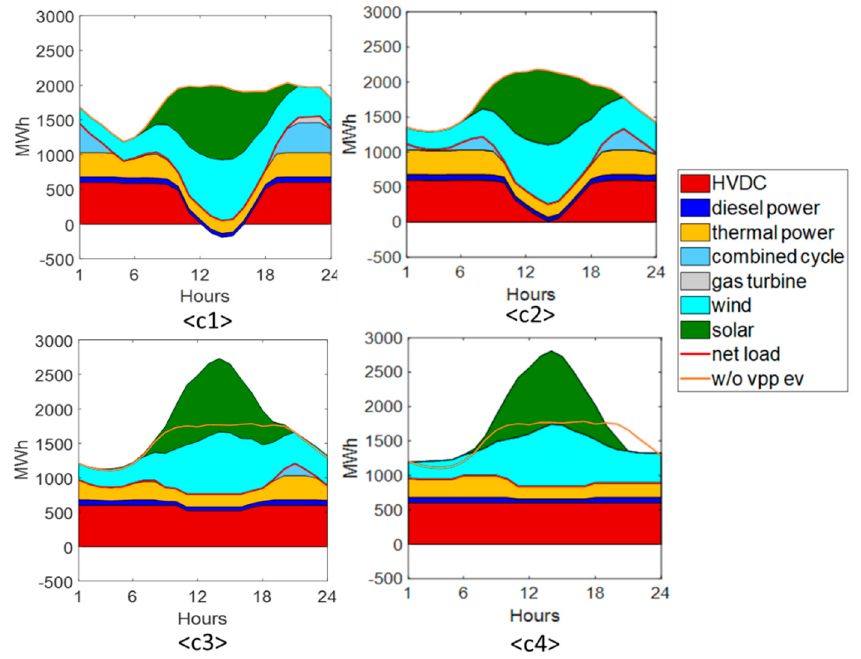
Figure 9. Expected dispatch profiles for a summer peak day in 2030.